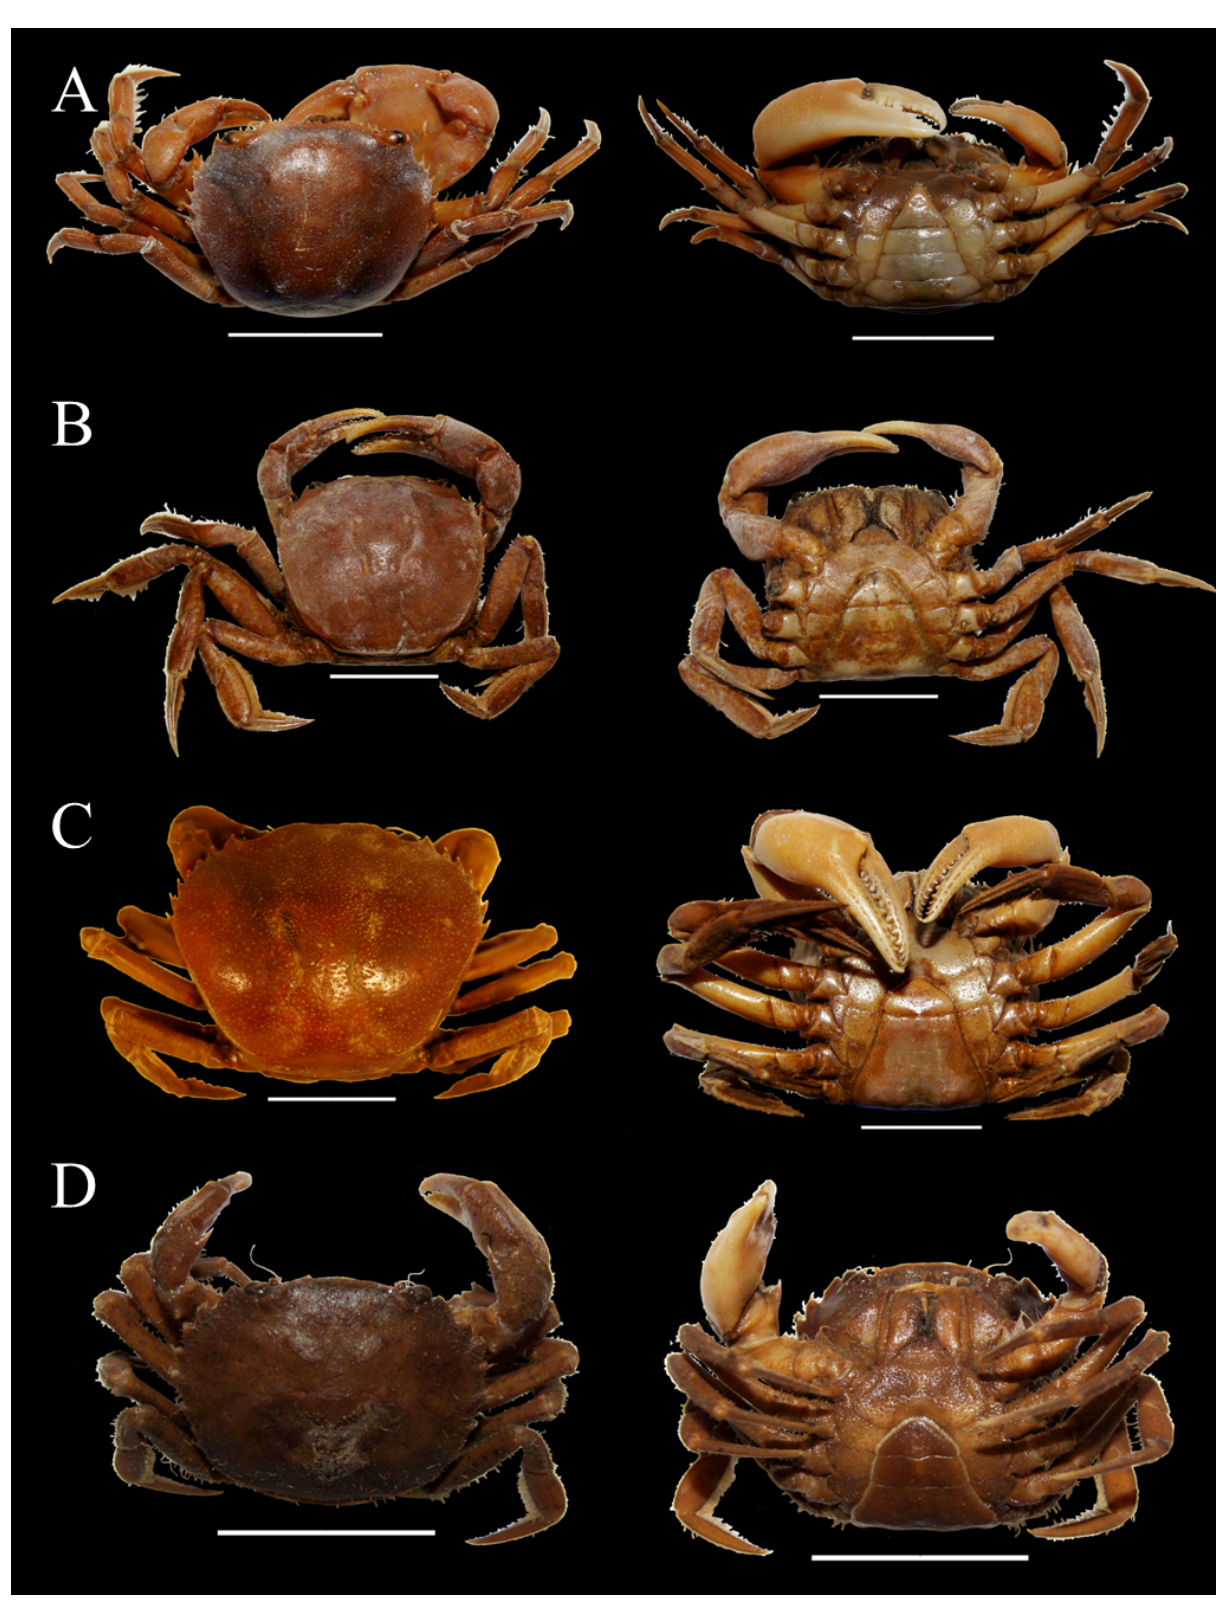
Figure 2. Habitus, dorsal (left side) and ventral views (right side) of A, Goyazana castelnaui ; B, Sylviocarcinus pictus ; C, Dilocarcinus septemdentatus ; D, Valdivia serrata . Scale: 2